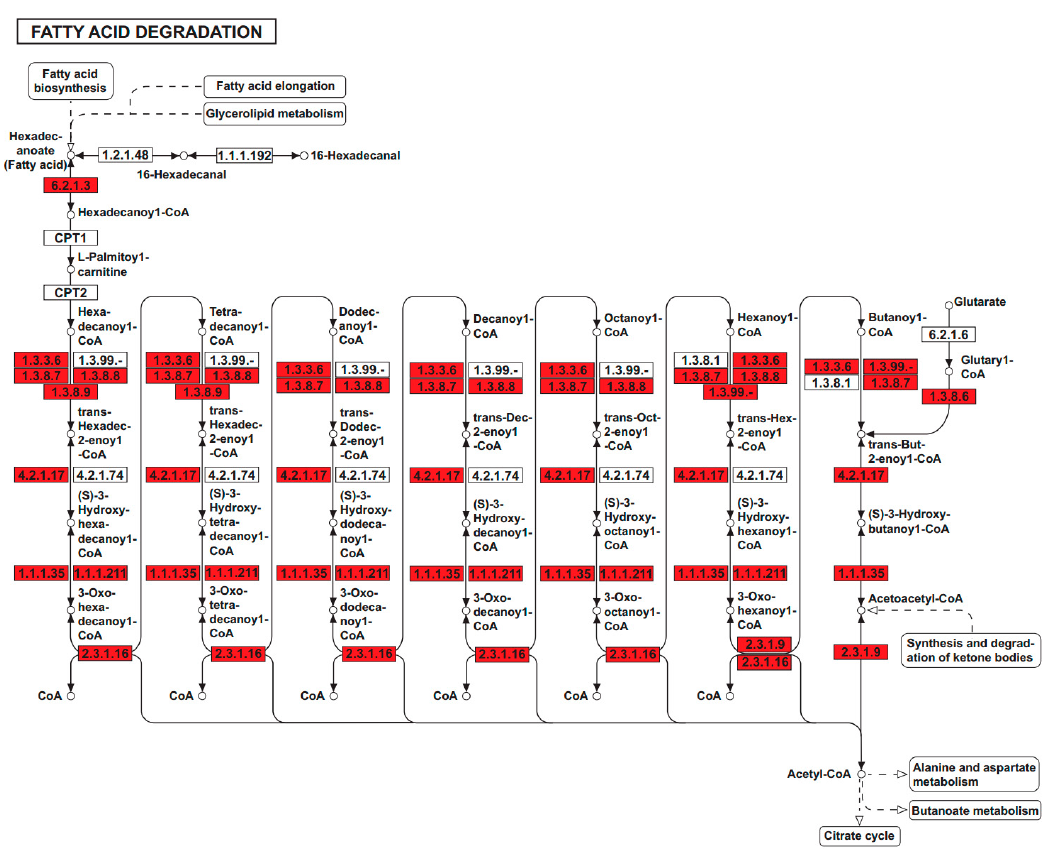
Figure 5. DL-specific DEG enrichment in the fatty acid degradation pathway. Enzymes encoded by upregulated genes in the DL pigs at 16 weeks are highlighted in red.